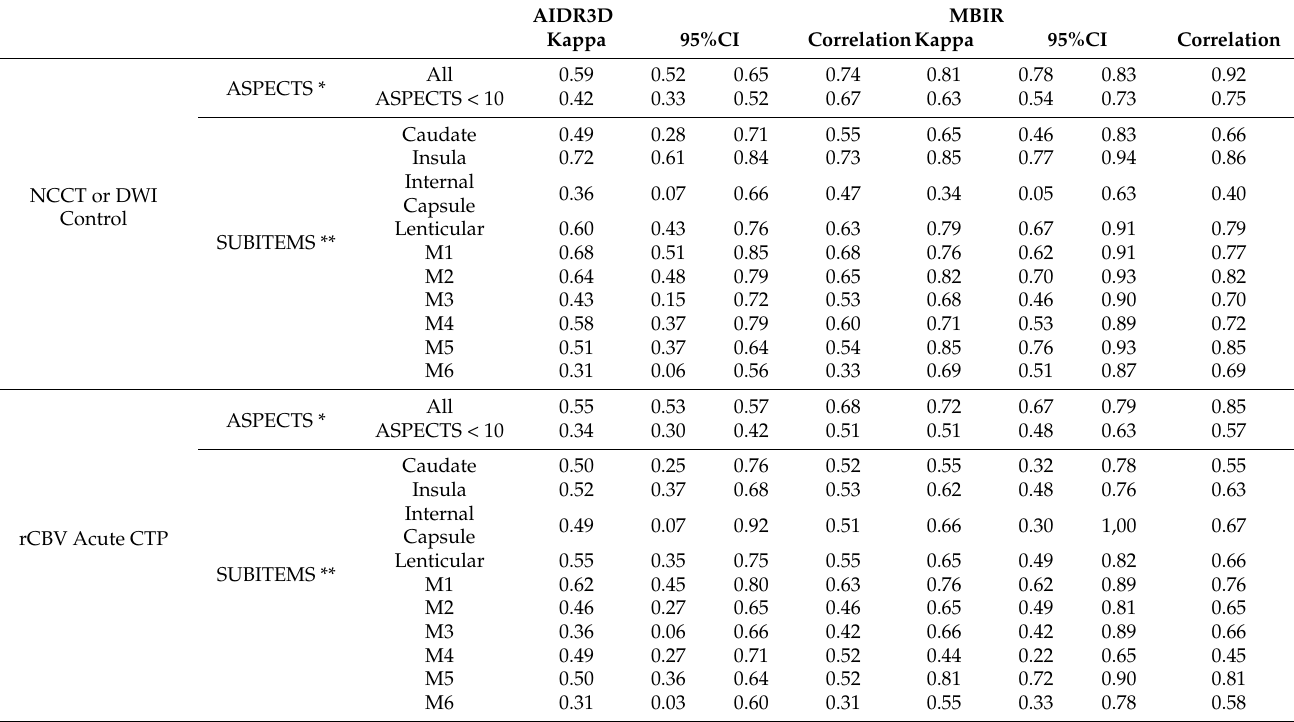
Table 1. Inter-technique agreement.